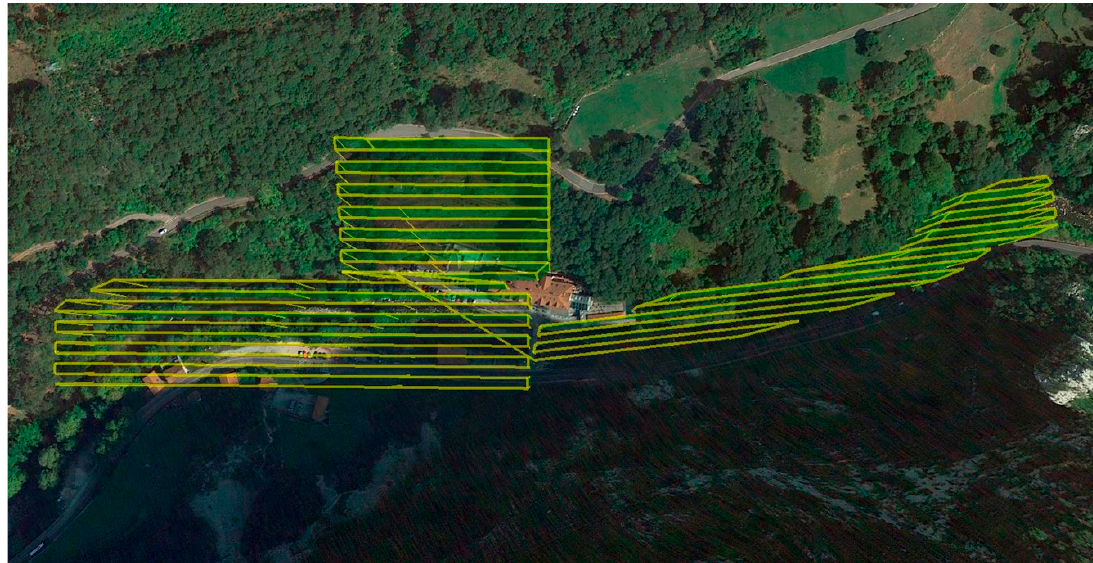
Figure 3. Flight geometry on simple grid configuration performed over the riverbed and spa facilities. Table 3. Flight plan parameters.